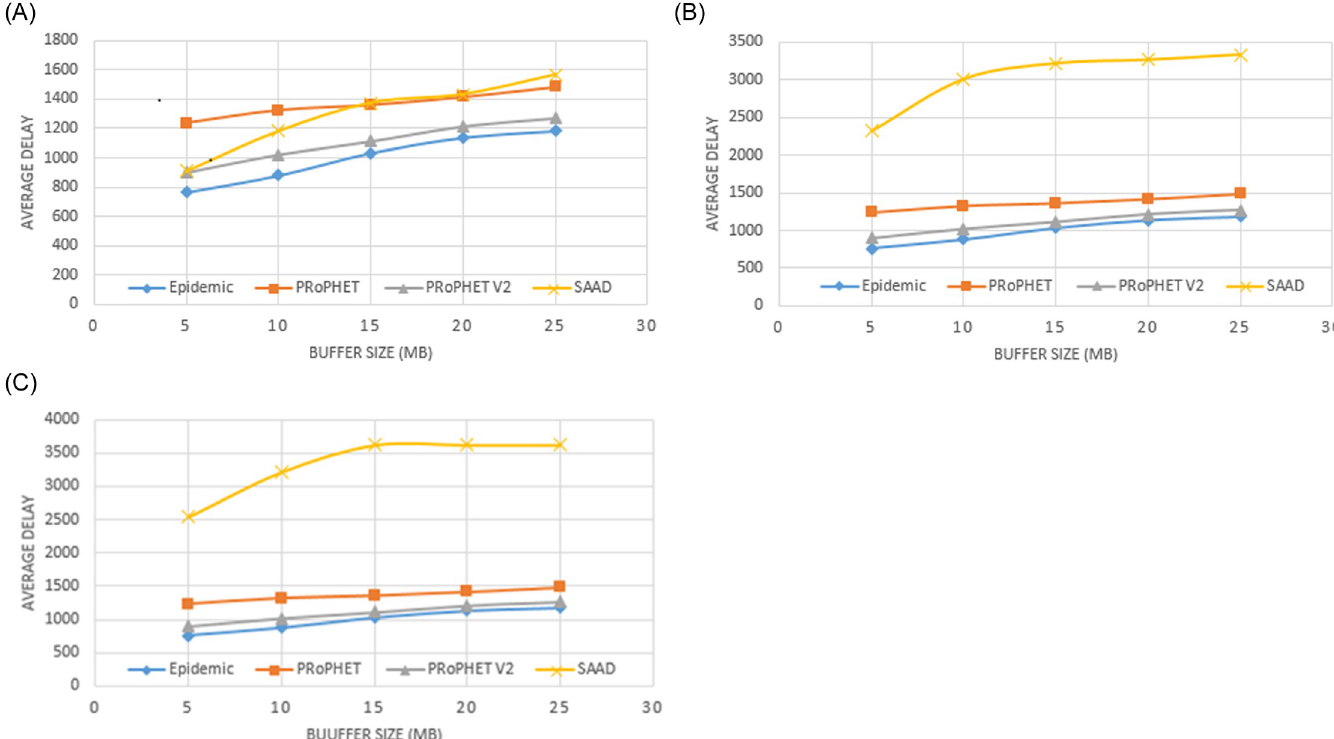
Fig 8. A. Average end-to-end Delay with different buffer capacity and DC (threshold = 0). B. Average end-to-end Delay with different buffer capacity and DC (threshold = 2). C. Average end-to-end Delay with different buffer capacity and DC (threshold = 4).